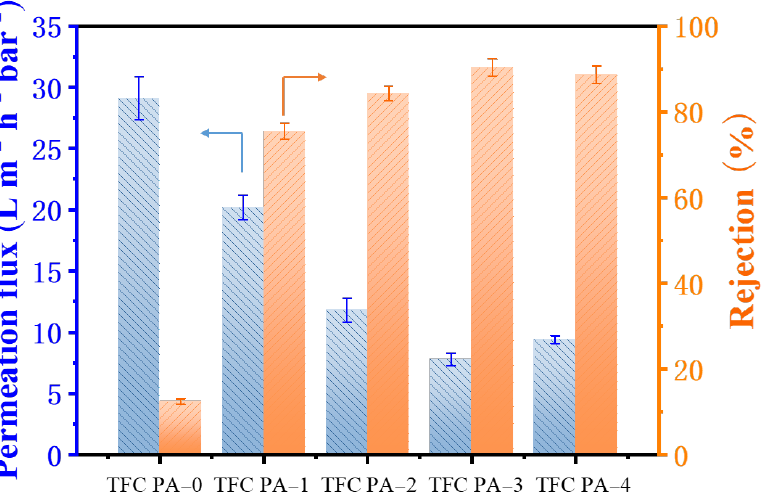
Figure 6. Permeate flux and dye rejection of the TFC OSN membranes with different CNT deposi- tion amounts for the methyl orange/methanol solution (The arrow points to the corresponding Y-